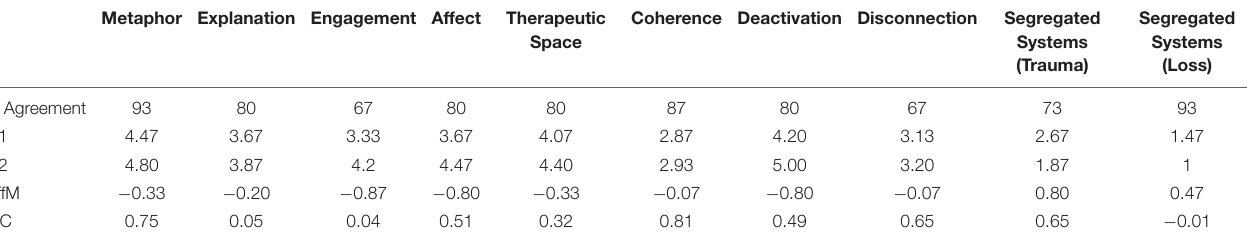
TABLE 2 | Inter-rater reliability statistics: percentage agreement (% Agreement), mean scores for the original coder (M1) and comparative coder (M2), the difference between these two mean scores (diffM), and the intra-class correlation (ICC)